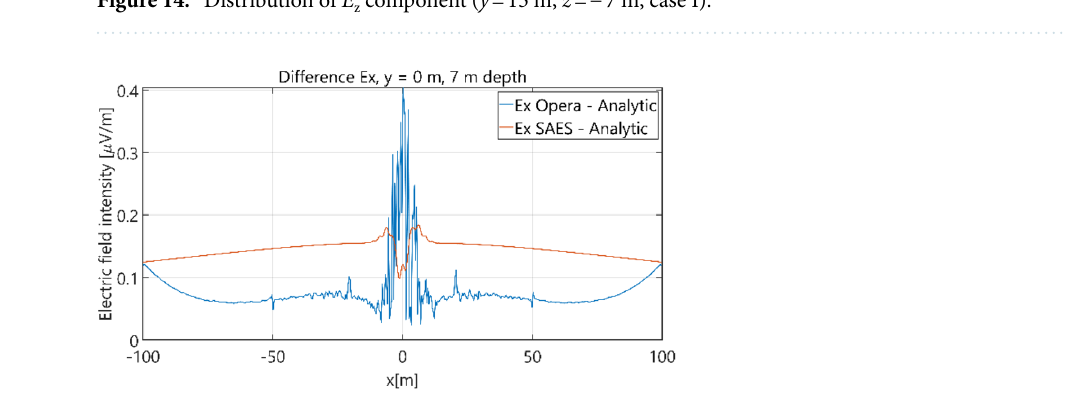
Figure 14. Distribution of E z component ( y = 15 m, z = − 7 m, case I).